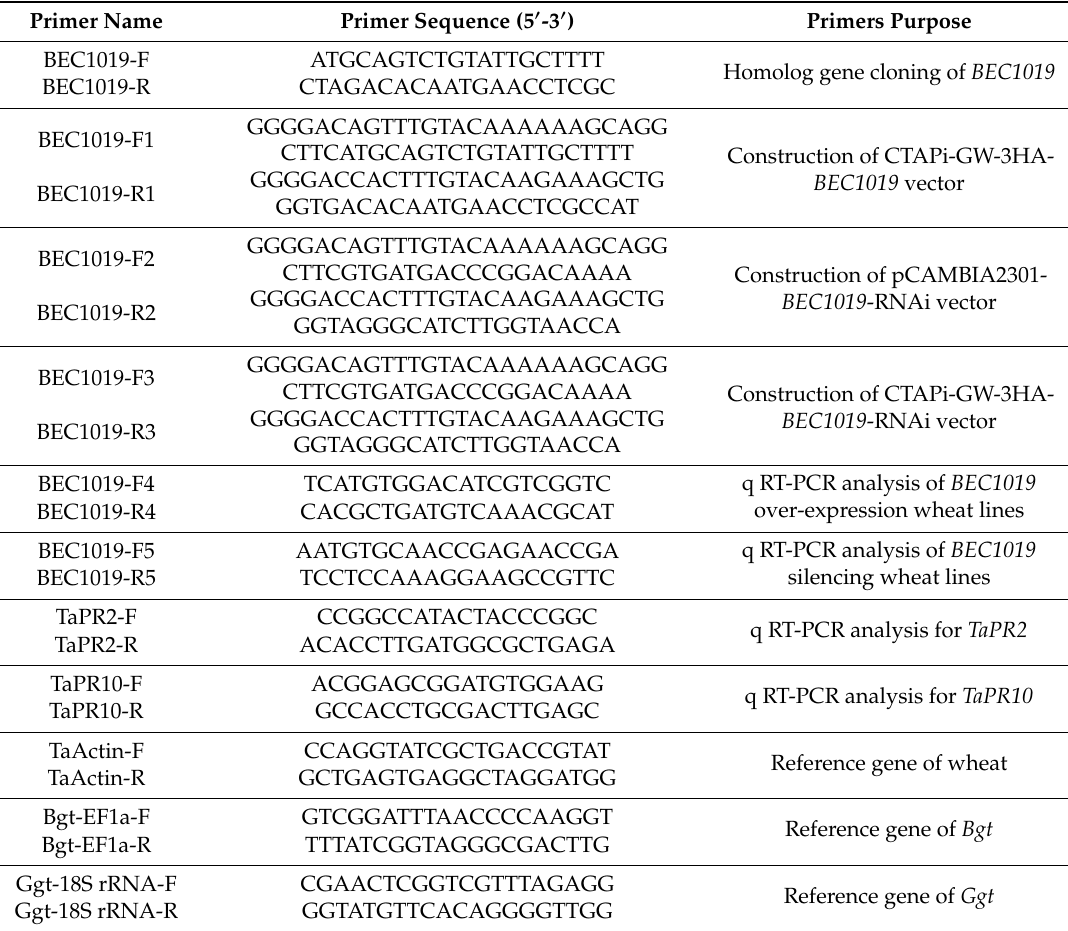
Table 1. Primers names and sequences used in this